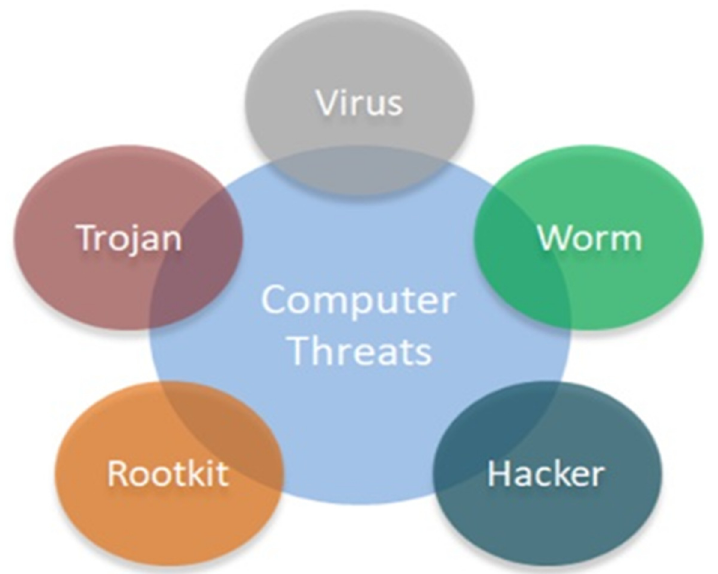
Figure 4. Common computer